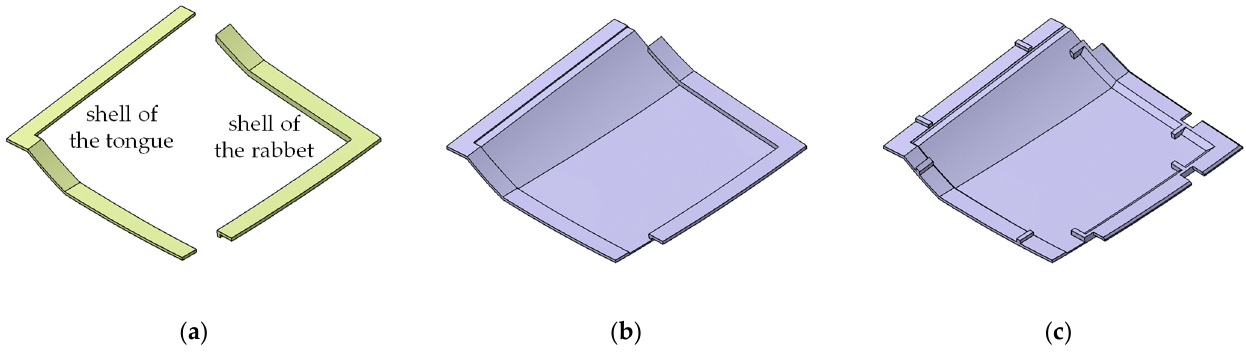
Figure 15. ( a ) Shells of the rabbet and tongue created by trimming of the surface offsets and boundary planes; ( b ) conversion and attachment of the shells to the cutout; ( c ) finished master segment with added chamfering, pin seats, and cutouts for connection.